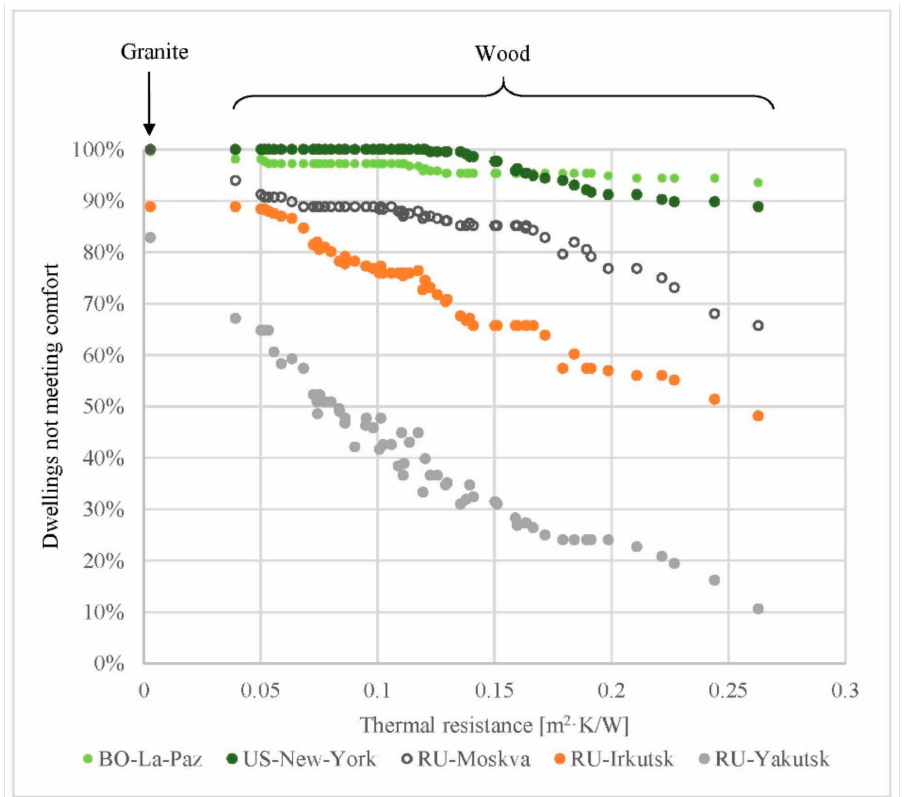
Figure 12. Mean percentage of dwellings meeting the minimum comfort requirement of 14 h a day with top ≥ 20 ◦ C versus thermal resistance of covering for five selected